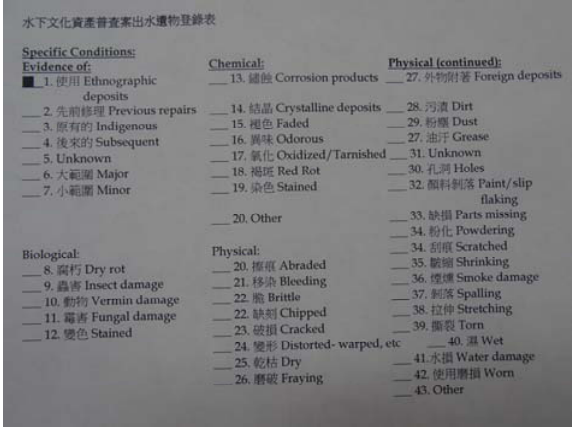
Figure 6. Case Study of the Underwater Object Condition